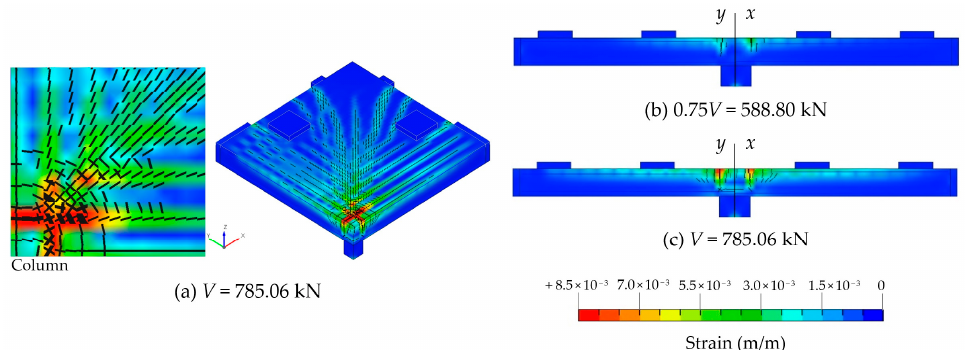
Figure 11. Cracking pattern on M4